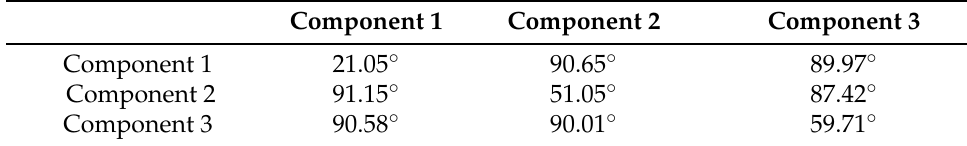
Table 2. Median Angle Between Components Across Trial and Subject